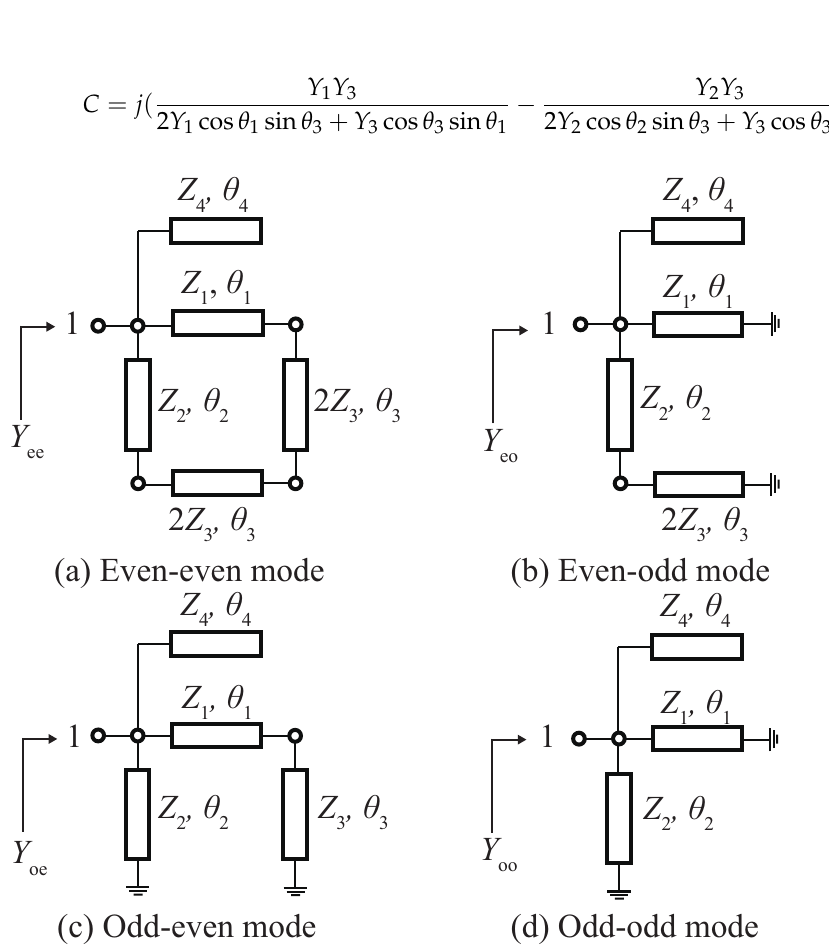
Figure 2. Equivalent circuits of the proposed